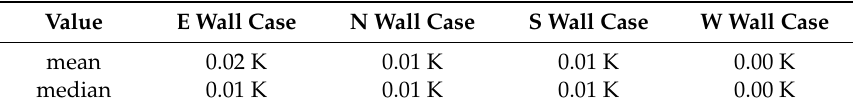
Table 1. Means and medians for different cases of placing green wall in the context of the whole atrium interior air temperature.